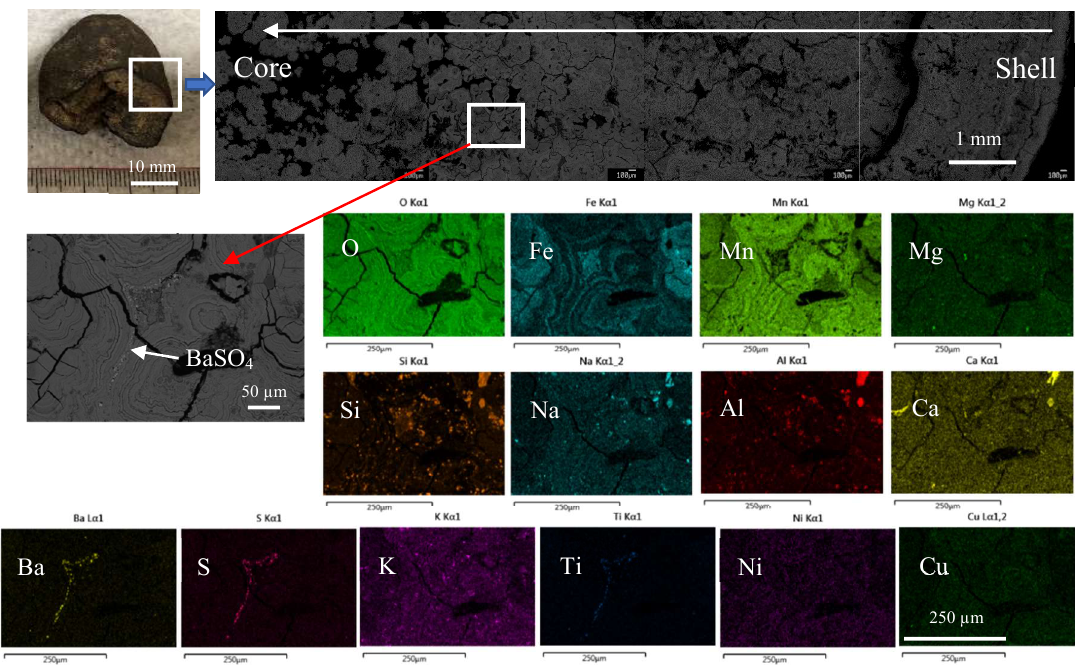
Figure 1. Microstructure and element distribution measured by SEM-EDS.